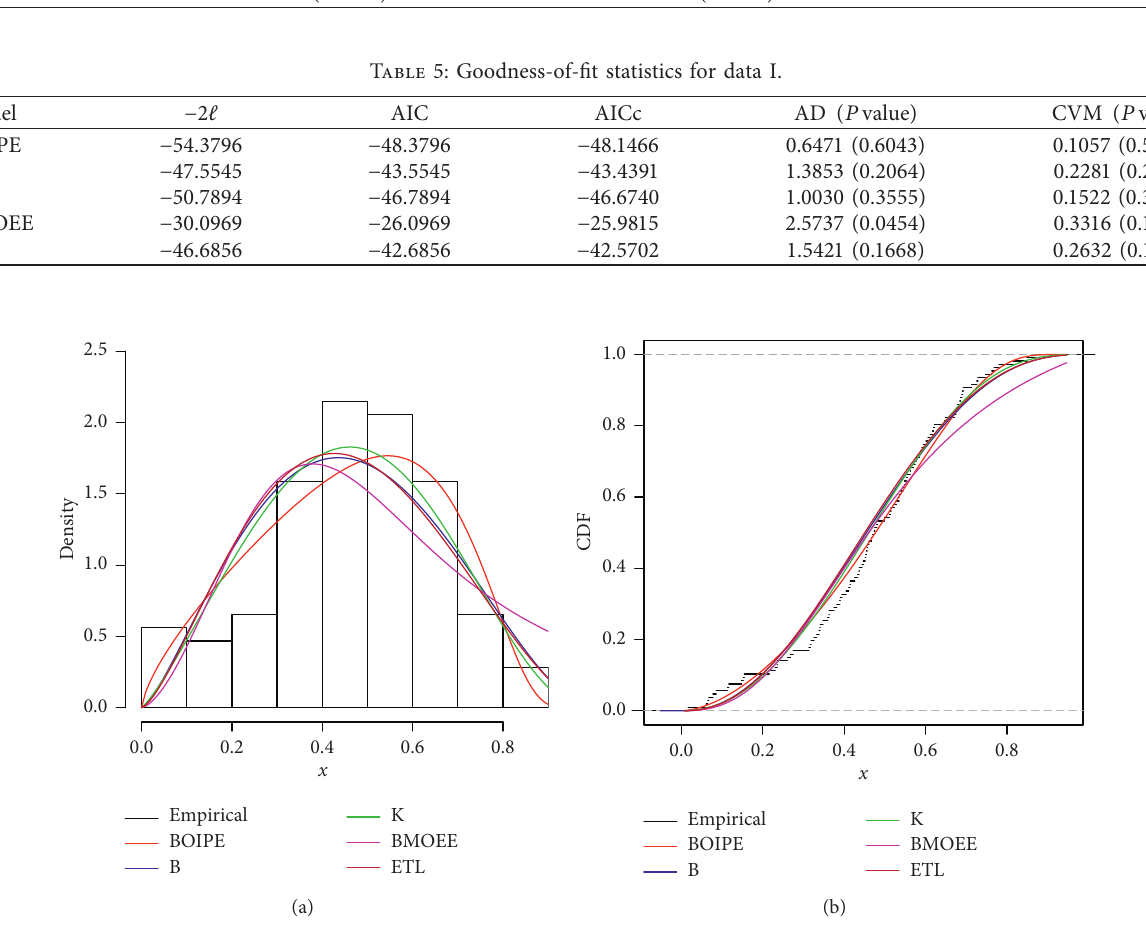
Figure 4: Plots of PDF (a) and CDF (b) of fitted distributions for data